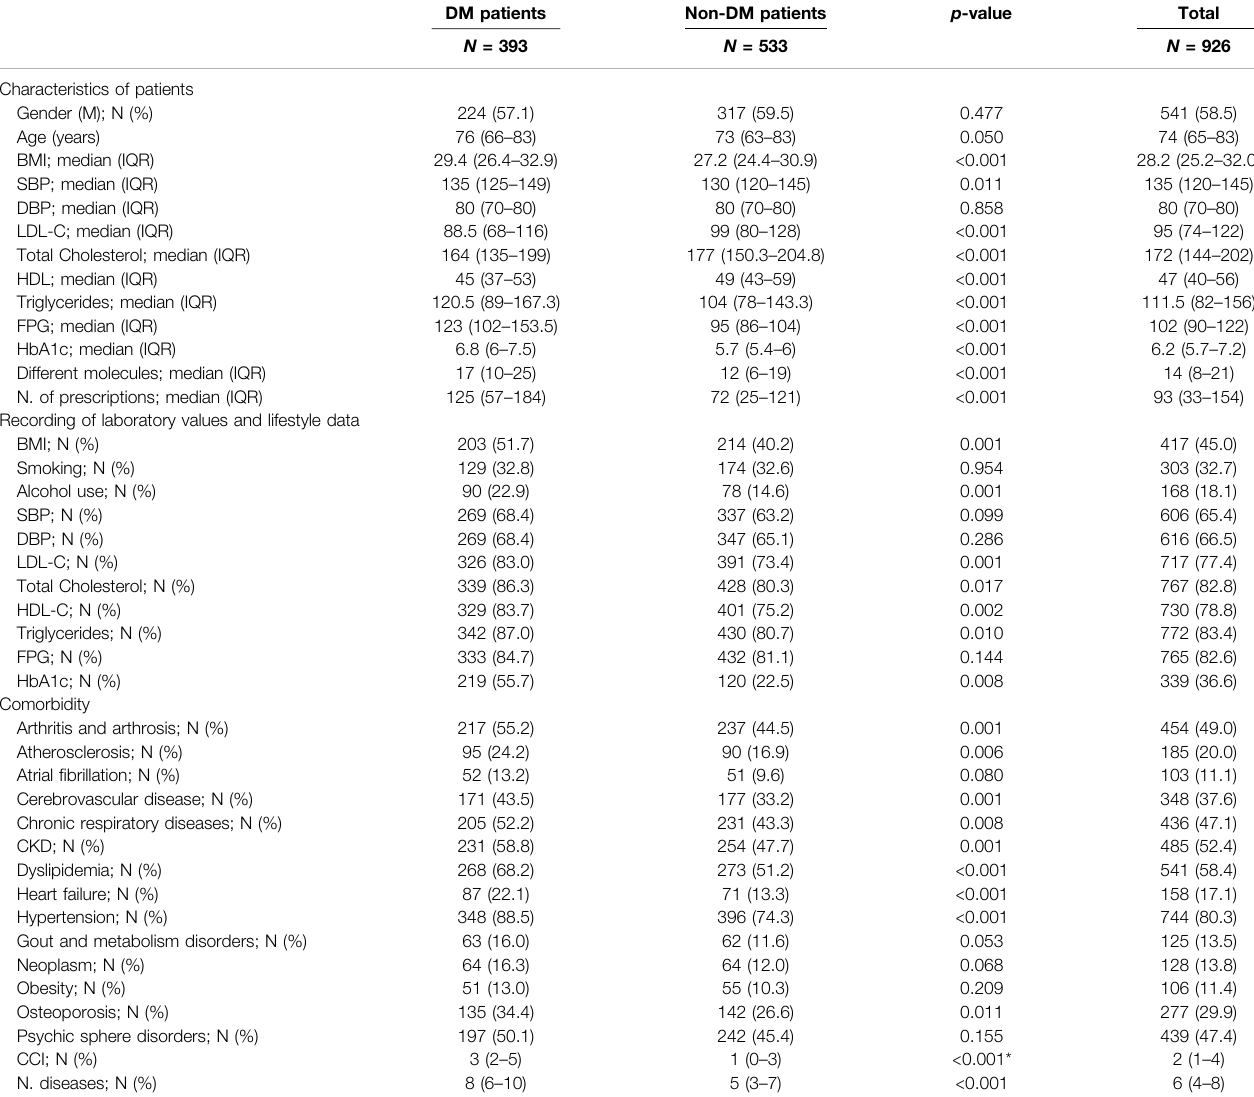
TABLE 1 | Characteristics of diabetic and non-diabetic patients affected by CAD. DM patients Non-DM patients p -value Total N = 393 N =